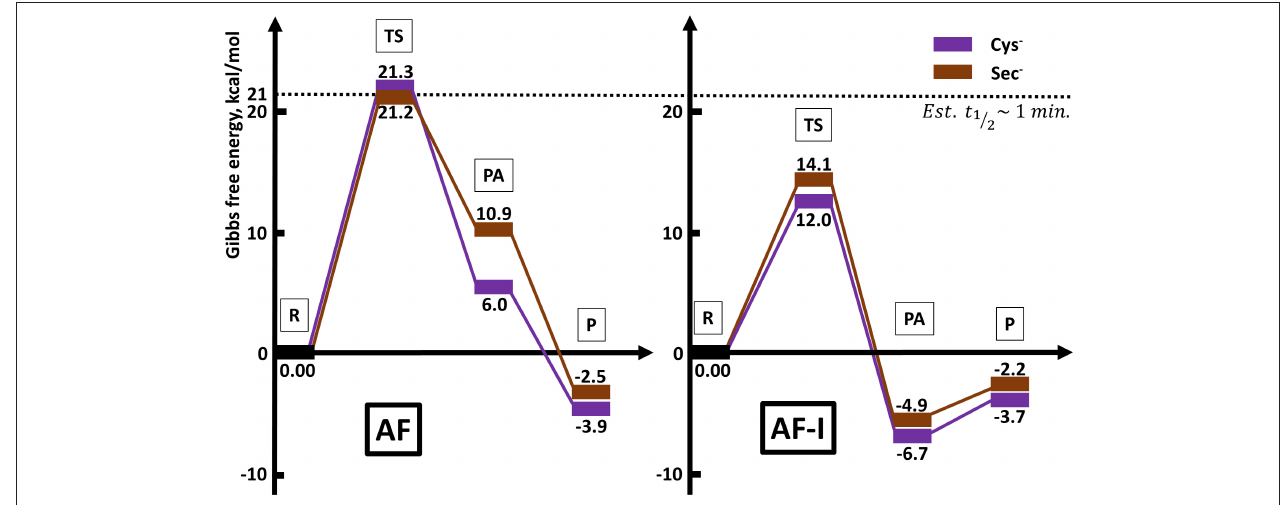
FIGURE 6 | Reaction profiles for AF and AF-I interacting with neutral His and Met and anionic Cys − and Sec − nucleophiles.